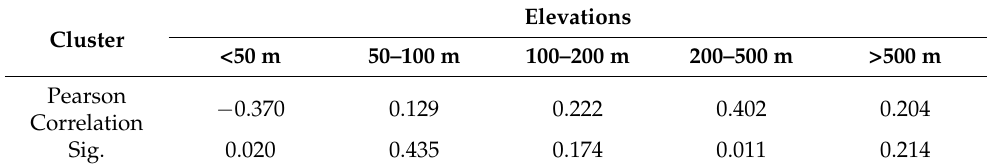
Table 13. Correlations between road restoration clusters and affected factors in Miyagi prefecture. Road Measured Road Road Population Closure Rate Seismic Cluster Importance Density Density Due to Snow Intensities Pearson Correlation